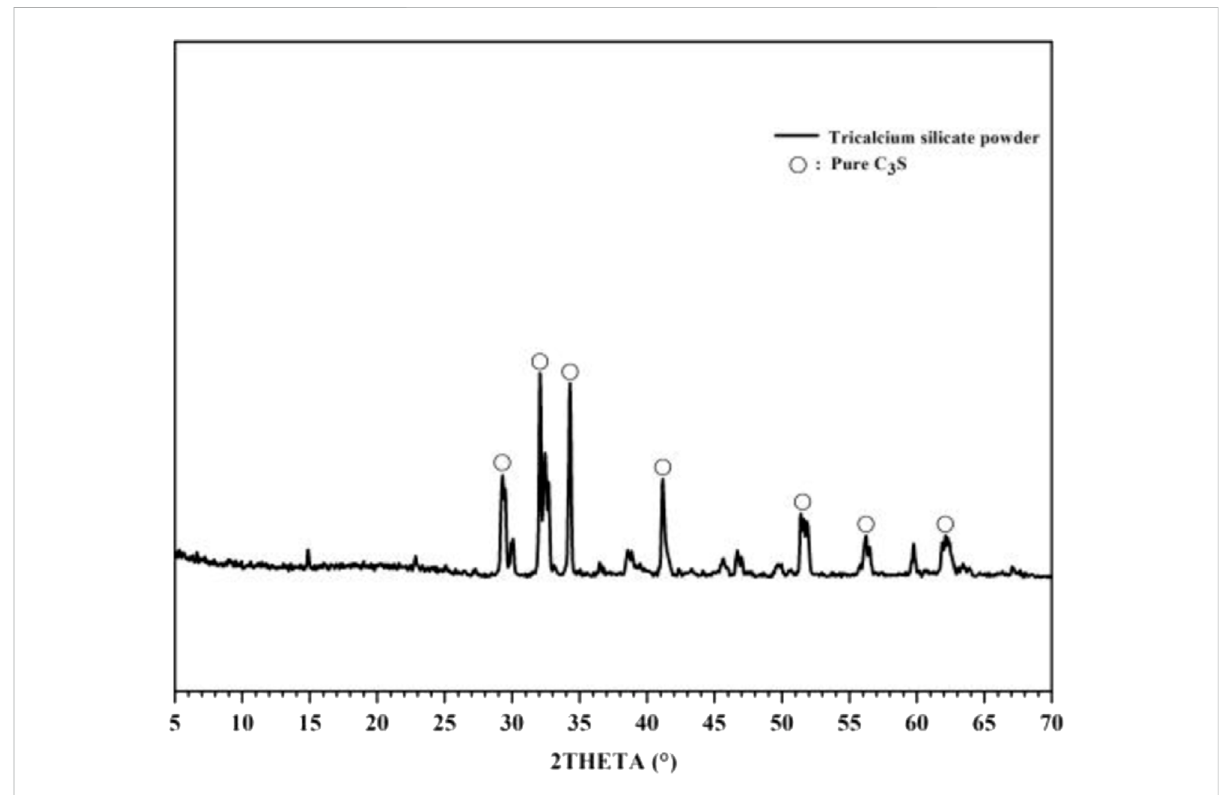
FIGURE 2 XRD results of experimental powders and main crystal